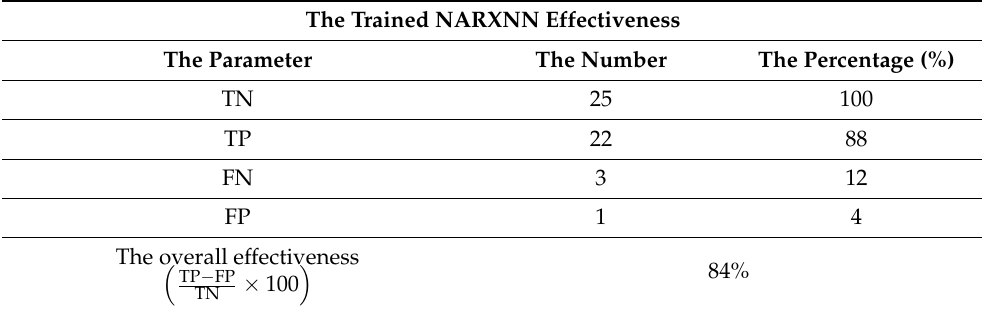
Table 2. The effectiveness of the trained NARXNN considering the 25 executed random collisions. The Trained NARXNN Effectiveness The